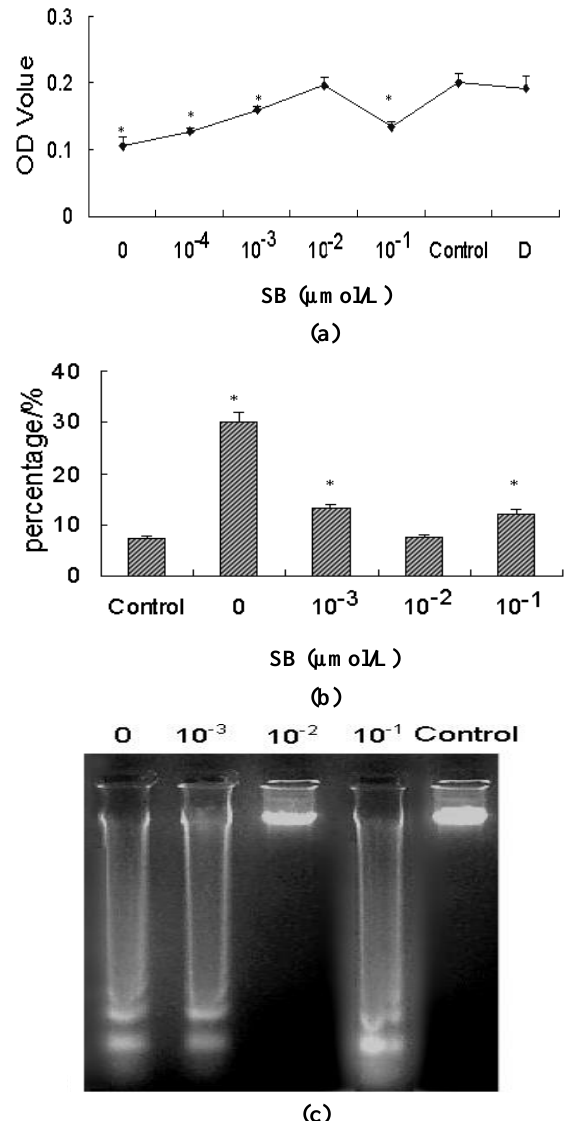
Figure 4. SB-431542 blocked the proliferation and apoptosis induced by TGF-  1 . The mammary epithelial cells were treated with SB-431542 of different concentrations (0, 10 -4 , 10 -3 , 10 -2 and 10 -1  M) for 1 h, then treated with 10 ng/ml of TGF-  1 . (a) The proliferation of mammary epithelial cells detected by MTT method. The group without any treatment is defined as the control, and D is DMSO blank vector group. (b) The apoptosis ratio of mammary gland epithelial cells detected by flow cytometry. * Indicates a significant difference between groups (p<0.01). (c) The detection of DNA integrity in mammary gland epithelial